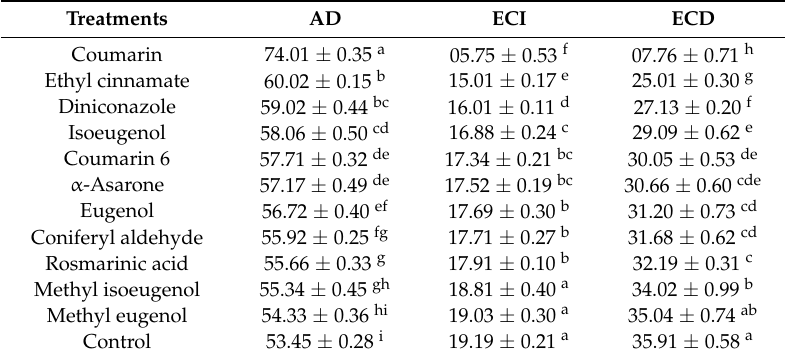
Table 2. Nutritional indices of red palm weevil larvae against different